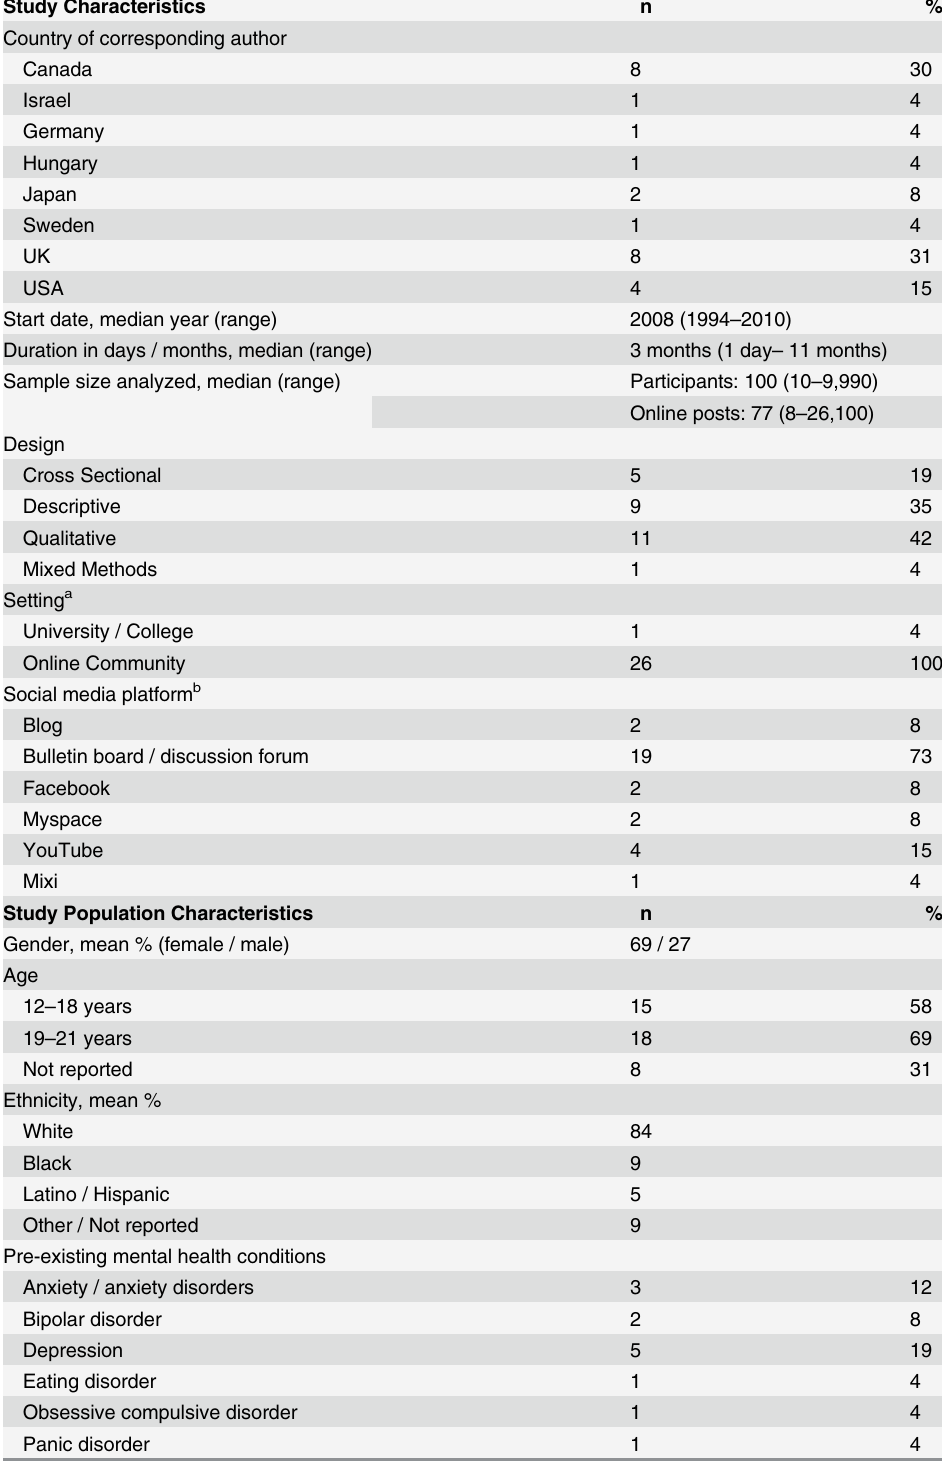
Table 1. Description of included studies (n = 26). Figures are number, percentage unless otherwise stated. Study